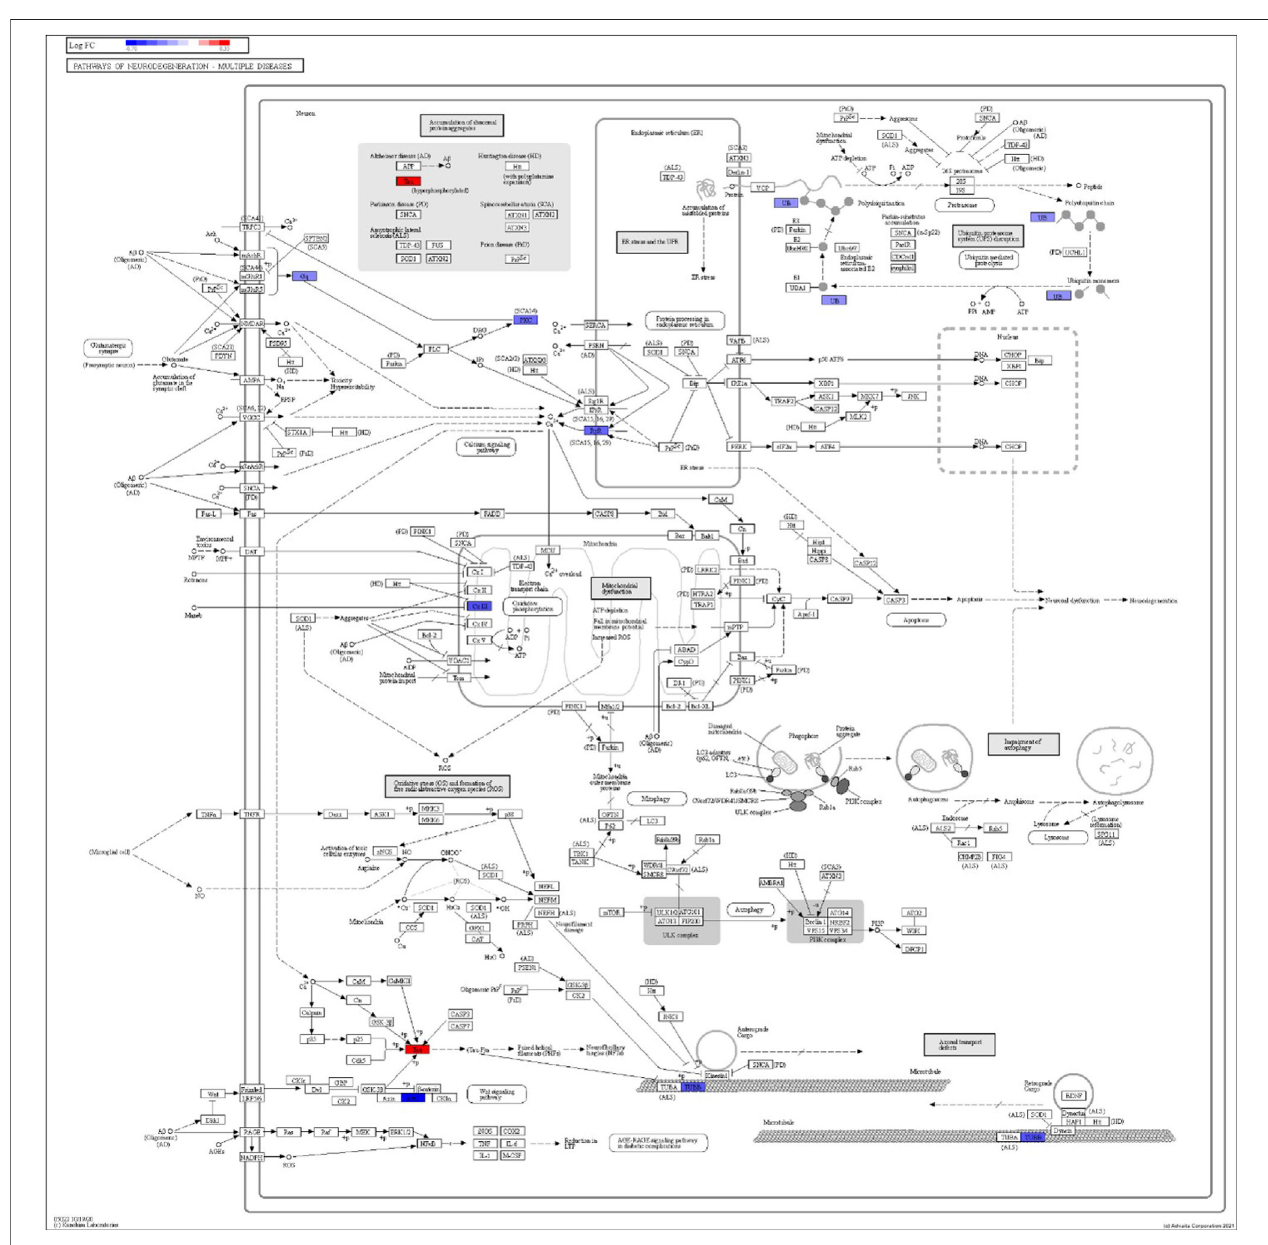
FIGURE 7 | iPathwayGuide analysis shows the differentially regulated genes in the KEGG neurodegeneration pathway (multiple diseases) in the astrocytes of the AD group (AD00205) compared to the astrocytes of the healthy control group (AD00201).